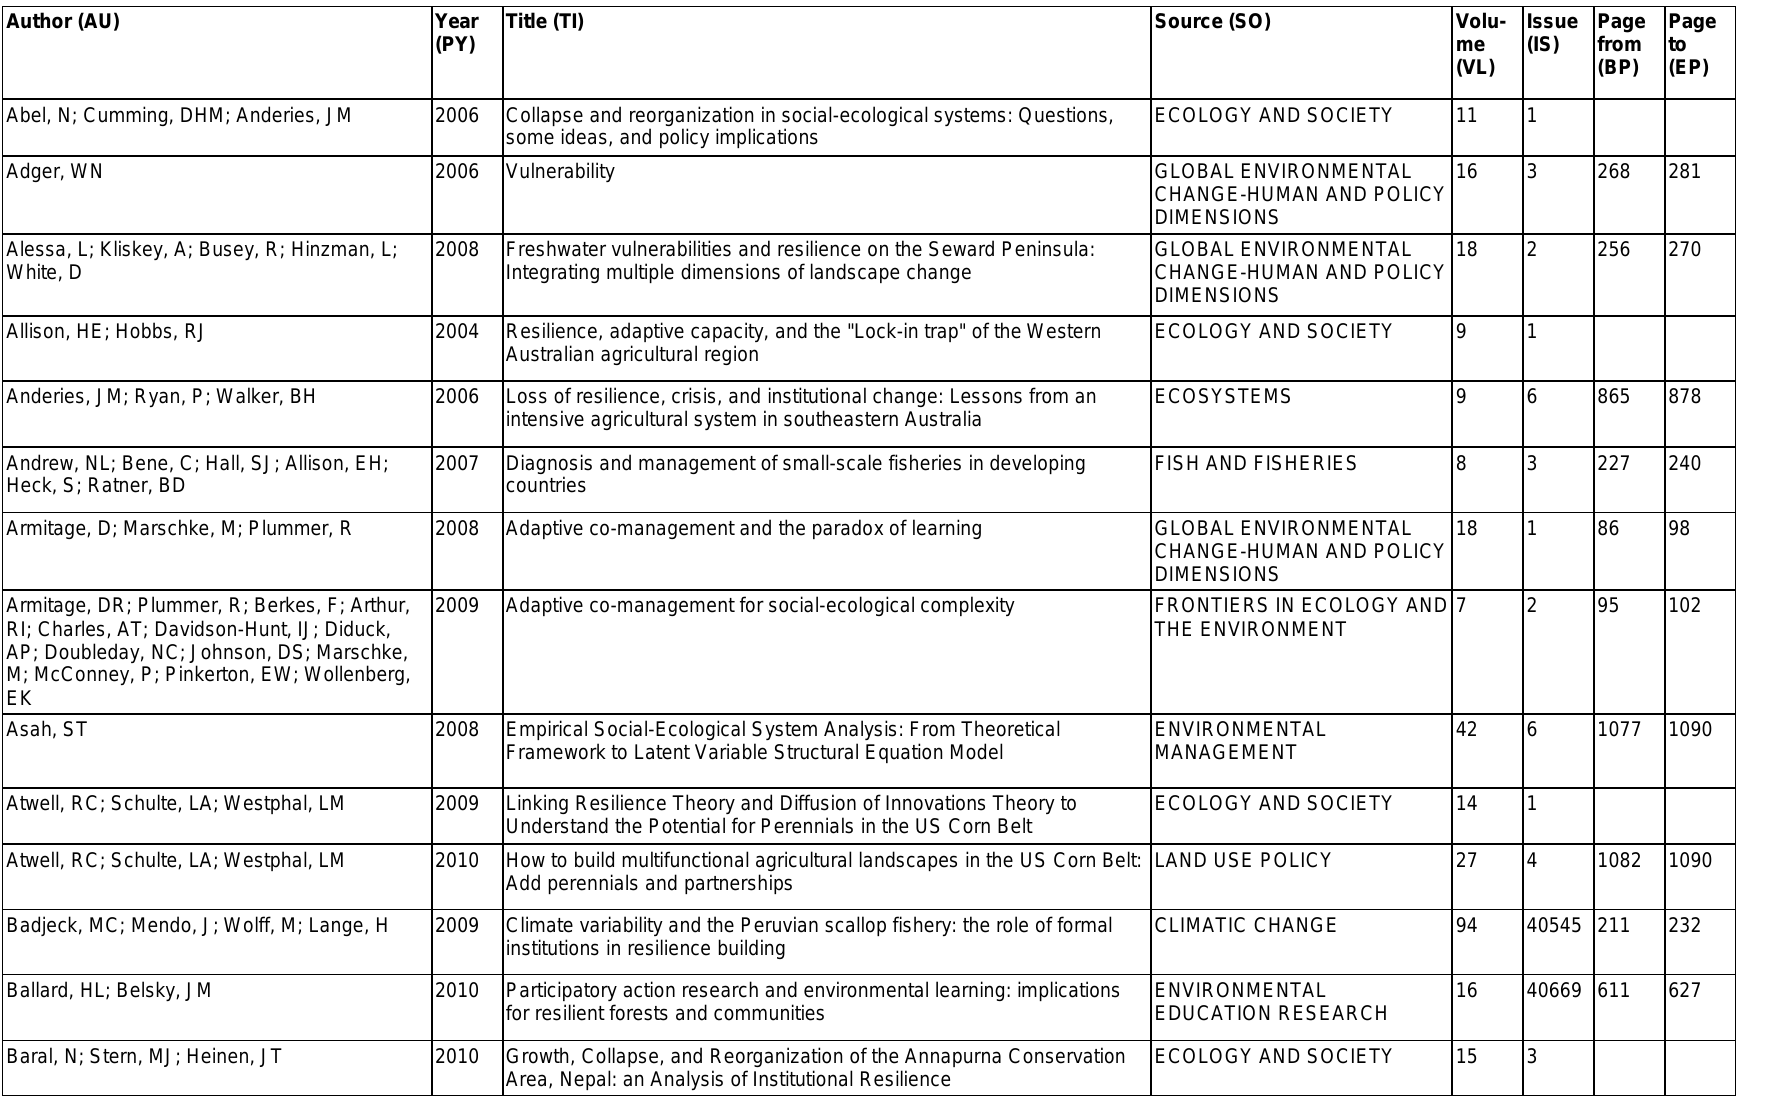
Table A3 . List of all 183 papers for the structured literature review. Author